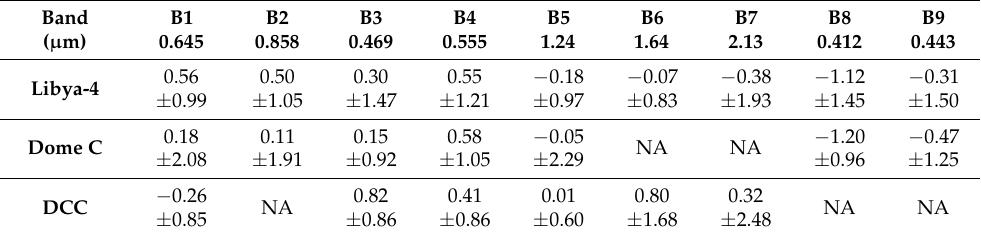
Table 4. Aqua MODIS RSB stability for the Libya-4, Dome C, and DCC approaches. Results are provided in percentage for drift during the 2012–2021 period. Values denoted as ± are the standard error. Those marked “NA” are either not applicable or a data